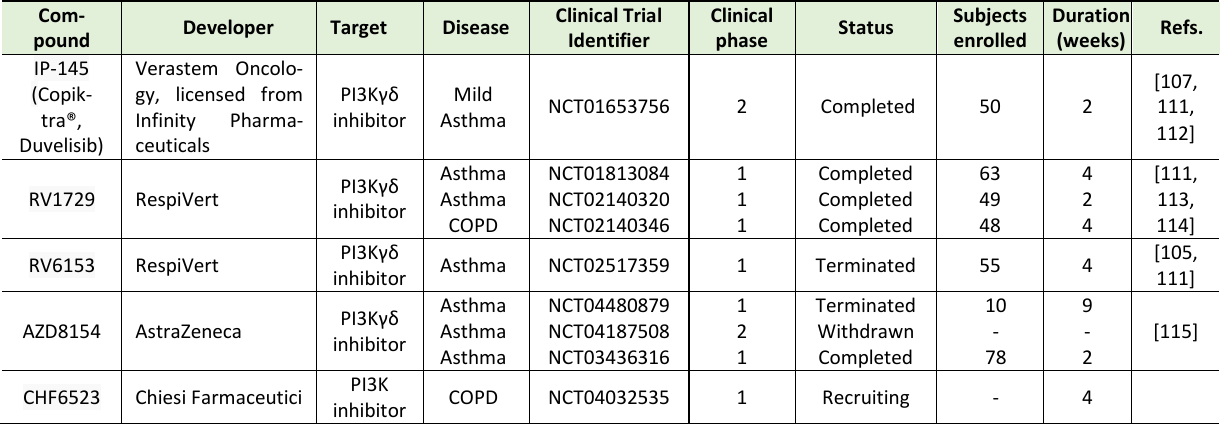
TABLE 2. Clinical development of PI3Kγδ inhibitors for respiratory diseases.